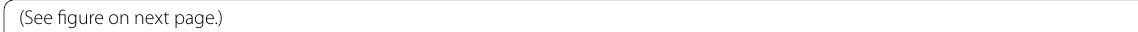
coleoid(See figure on next Fig. 3 Details of the head and arm crown of the predator ( Jeletzkyteuthis coriacea ), SMNS 70623, Early Toarcian, Semicelatum to lowermost Serpentinum Zone, Ohmden, Germany. a Overview of the fossil with a rectangle showing the localisation of the details shown in b , c . b Detail of showing head and arm crown still surrounding the posterior end of the prey